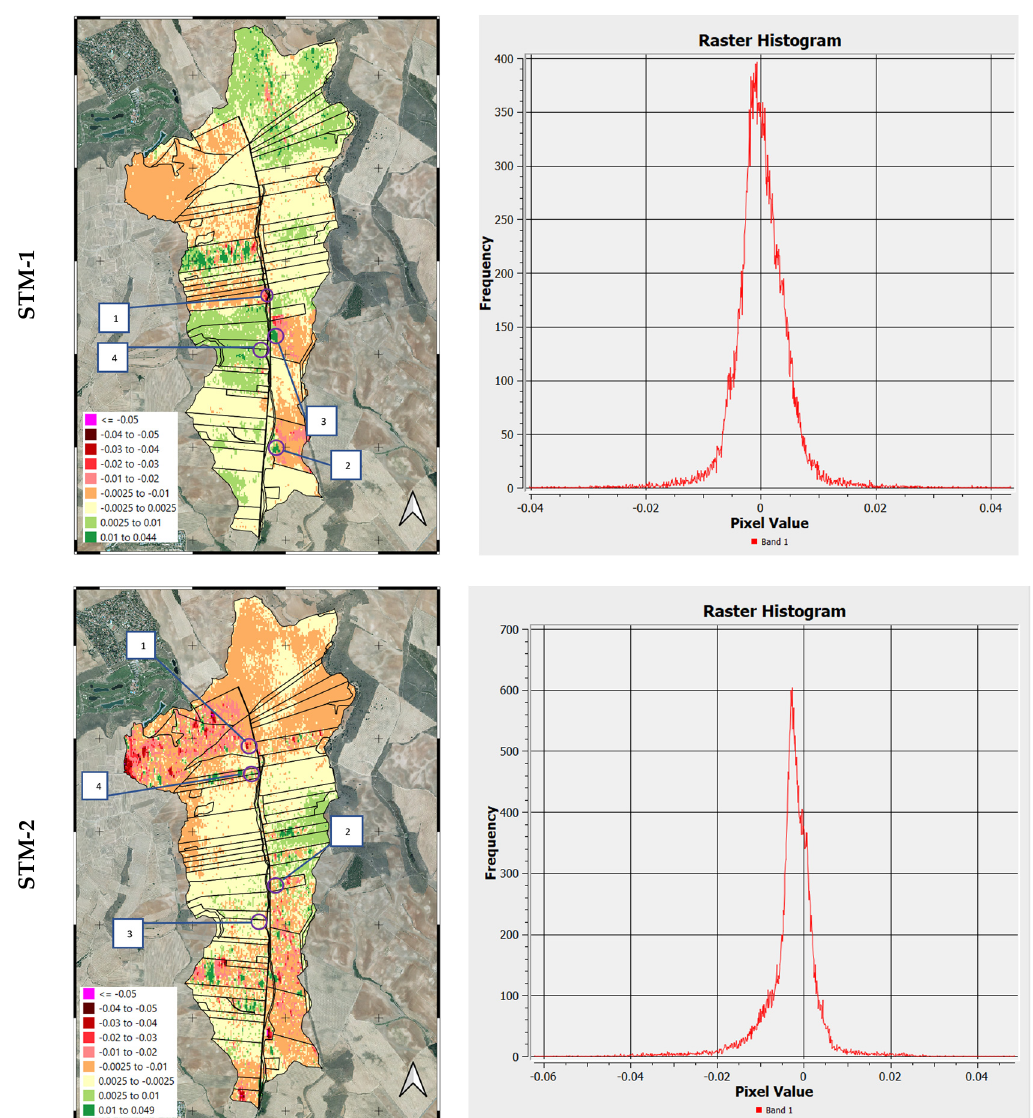
Figure 12. Corrected deformation raster in metres (m) between 28 February–6 March 2018 (STM-1), 16–28 August 2019 (STM-2), and their histogram. Callouts marks in the picture on the left are explained in Figures 13 (STM-1) and 14 (STM-2). Zebra frame segments of 1 km.